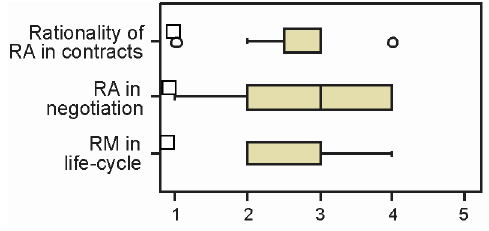
Fig. 2. Organizational use of risk allocation & management